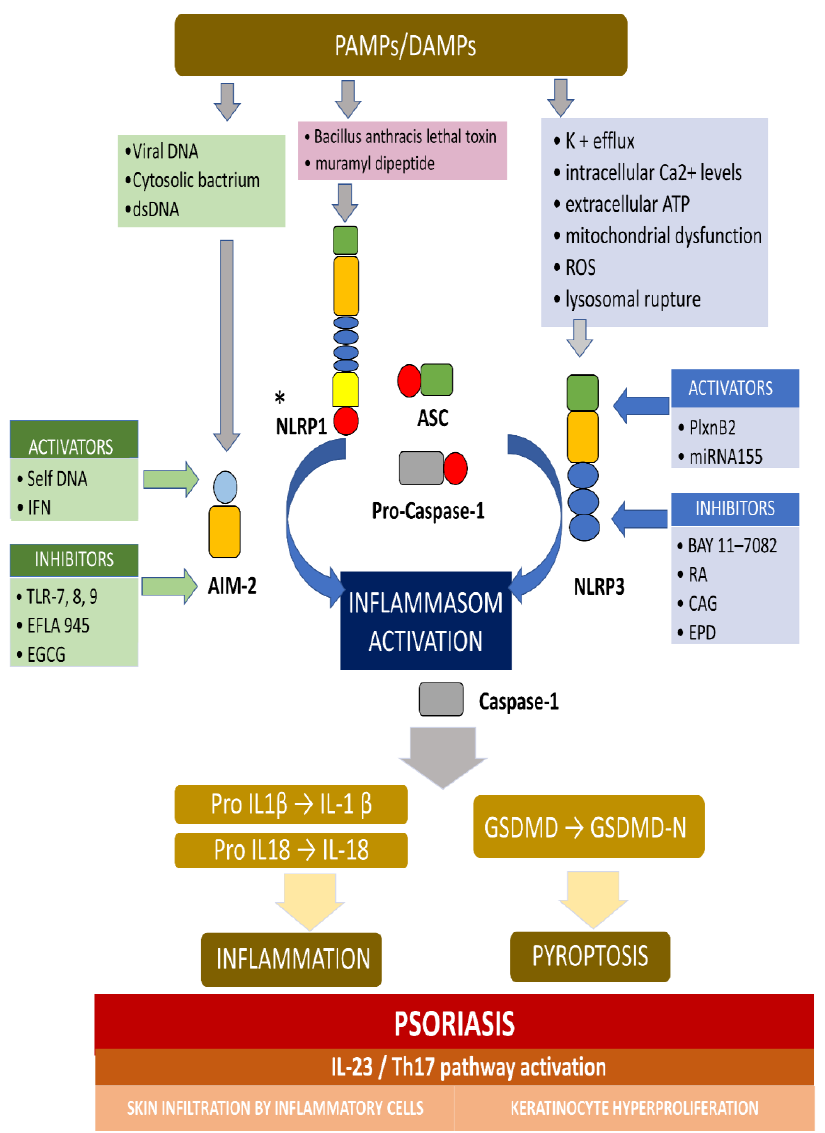
Figure 2. The activation and inhibition of the AIM2 and NLRP3 inflammasome in psoriasis. * Activa- tors and inhibitors are not reported for NLRP1. The AIM2 inflammasome detects cytosolic dsDNA, including DNA viruses and cytosolic bacterium, which causes inflammasome activation. The NLRP3 inflammasome can be activated by a variety of PAMPs and DAMPs, which cause, for example, potassium efflux, extracellular ATP, lysosomal destabilization, intracellular calcium levels, and ROS (reactive oxygen species). When the main components of the inflammasome is connecting and the active inflammasome is formed, it directly recruits and cleaves pro-caspase1 into active caspase-1, which proteolytically activates the pro-inflammatory cytokines IL-1b and IL-18. In addition, the acti- vated inflammasome cleaves gasdermin D (GSDMD) into active N-terminal fragment (GSDMD-N), which drives a lytic type of cell death pyroptosis. In psoriasis, the self-DNA in patients, and IFN in keratinocyte in mouse activate AIM-2 inflammasome, while TLR-7/8/9 (toll-like receptor), EFLA 945 (red vine leaf extract), and EGCG (epigallocatechin-3-gallate) can inhibit the AIM2 inflammasome. In turn, PlxnB2/ligand and miRNA155 activate the NLRP3 inflammasome, while BAY 11-7082, rosmarinic acid (RA), cycloastragenol (CAG) and EPD (the effective part of Datura metel L .) inhibit this inflammasome. The active IL-1b and IL-18 activates IL23/Th17 pathway, inducing a numerous of inflammatory cytokines and chemokines. Different kinds of immune cells infiltrating into the skin and, finally, causing hyperproliferation in the epidermis, was